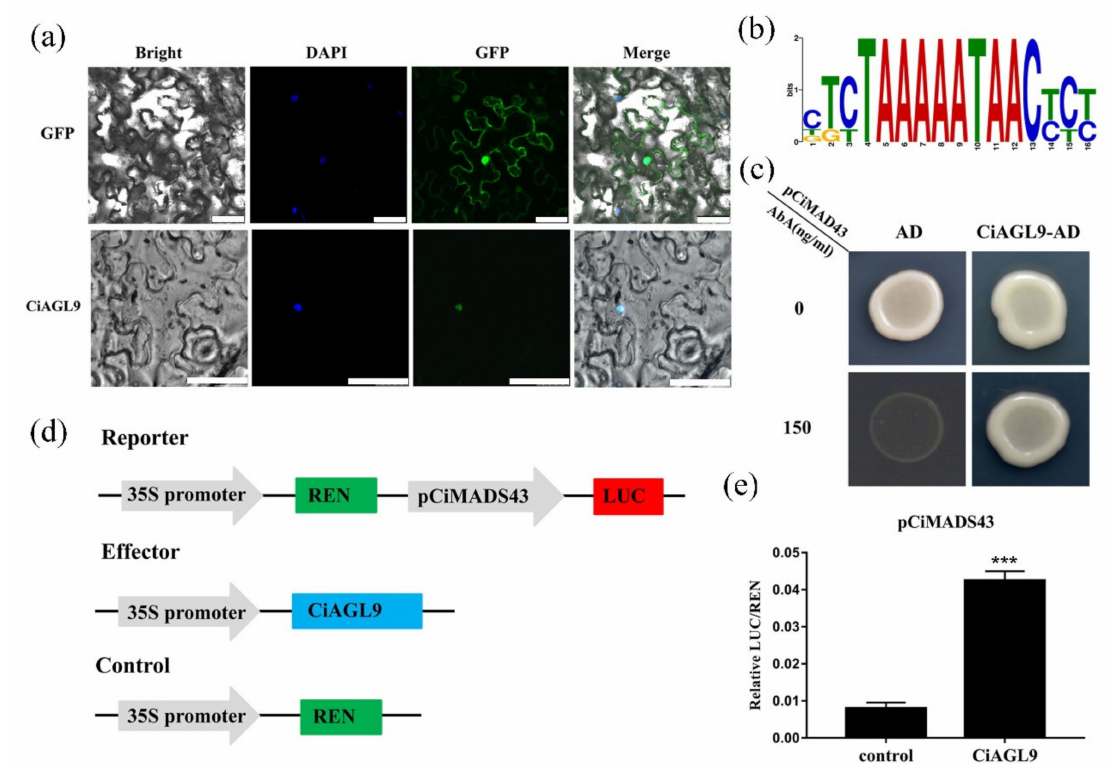
Figure 6. CiAGL9 binds to the CiMADS43 promoter. ( a ) Subcellular localization of CiAGL9 in tobacco leaves. GFP fused to the C -terminal region of CiAGL9, and the fusion protein was driven by 35S promoter. 4 (cid:48) ,6-diamidino-2-phenylindole (DAPI) staining showed the location of the nucleus and 35S::GFP was used as the positive control. Scale bar = 25 µ M. ( b ) Sequence of MADS-box protein binding site. ( c ) The interaction between the CiMADS43 promoter and CiAGL9 by yeast one-hybrid assay. pCiMADS43: 482 bp CiMADS43 promoter sequence was cloned into pAbAi vector. AD: pGADT7 empty vector. CiAGL9-AD: CiAGL9 fused with GAL4-AD. ( d ) Schematic diagrams of vectors used for the dual-luciferase (LUC) assay. ( e ) CiAGL9 activated the expression of CiMADS43. LUC reporter system was used in tobacco leaves. The relative LUC/REN were measured after 2 days of Agrobacterium infiltration. Statistically significant is marked with asterisk(s) (*** p < 0.001, Student’s t